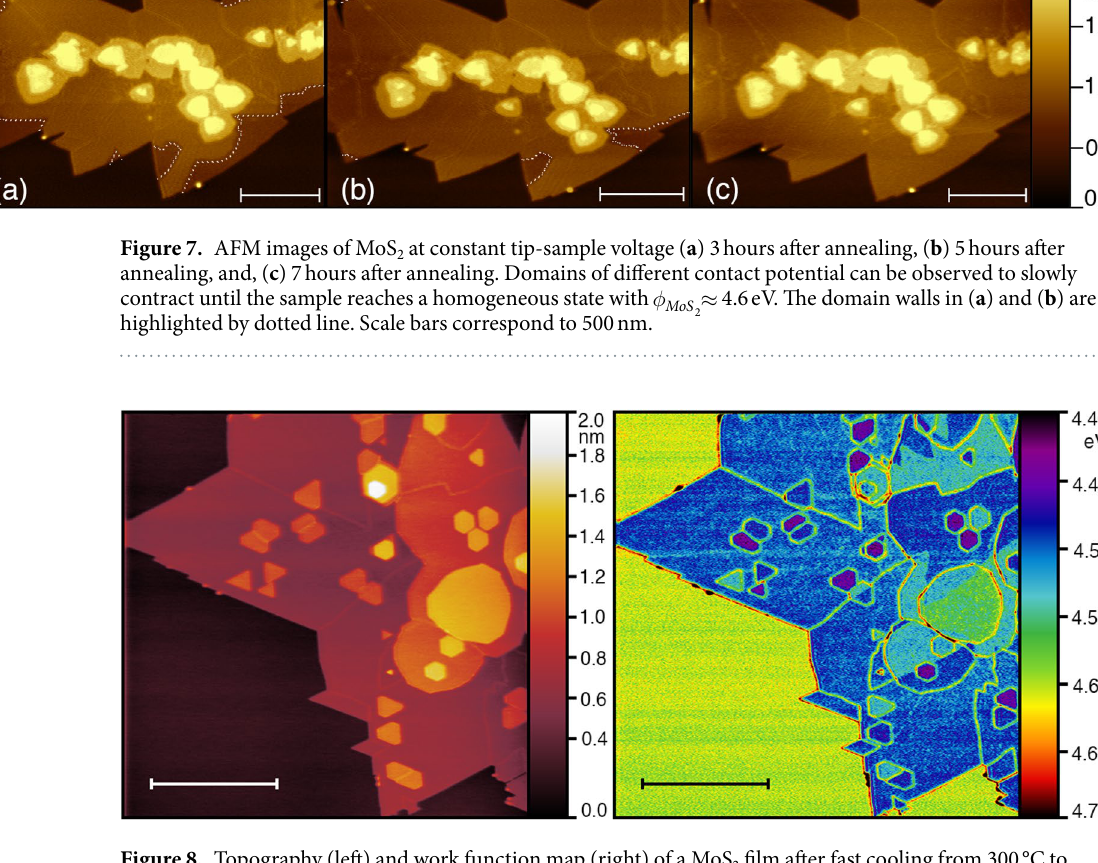
Figure 8. Topography (left) and work function map (right) of a MoS 2 film after fast cooling from 300 °C to room temperature. Stable domains with different work function on 2nd and 3rd layers are evident. The first layer (with exception of grain boundaries) is homogeneous with work function of roughly 4.5 eV. Scale bars indicate 1 μ